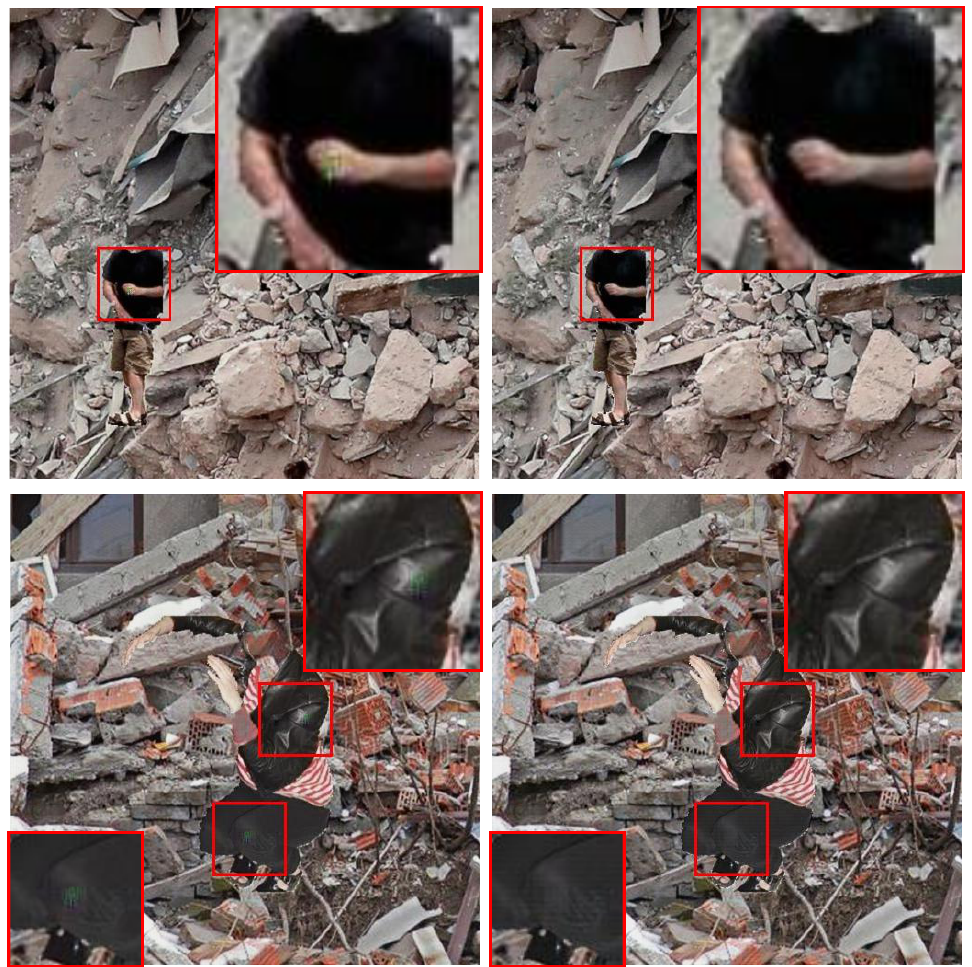
Figure 7. Visual comparison of only using the global discriminator and adding the local discriminator. The first column shows images harmonized by the network that only has the global discriminator, and we can see some green artifacts in the foreground. The second column shows the corresponding images generated by the network with both the global discriminator and the local discriminator. These artifacts are eliminated by introducing the local discriminators. We zoom in on some image areas for better